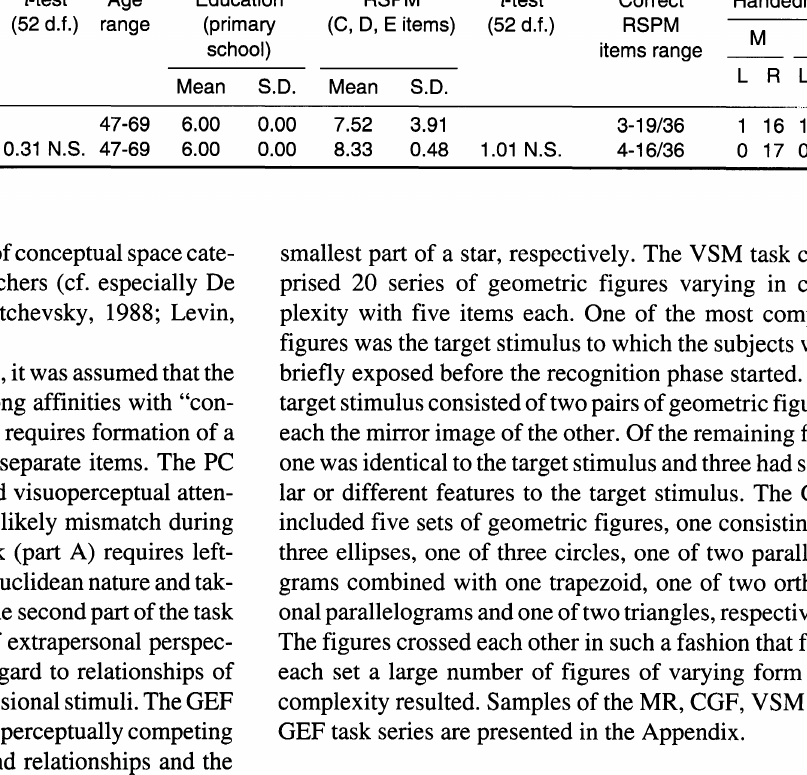
TABLE II. Matching variables of the PO patients and NC subjects Number